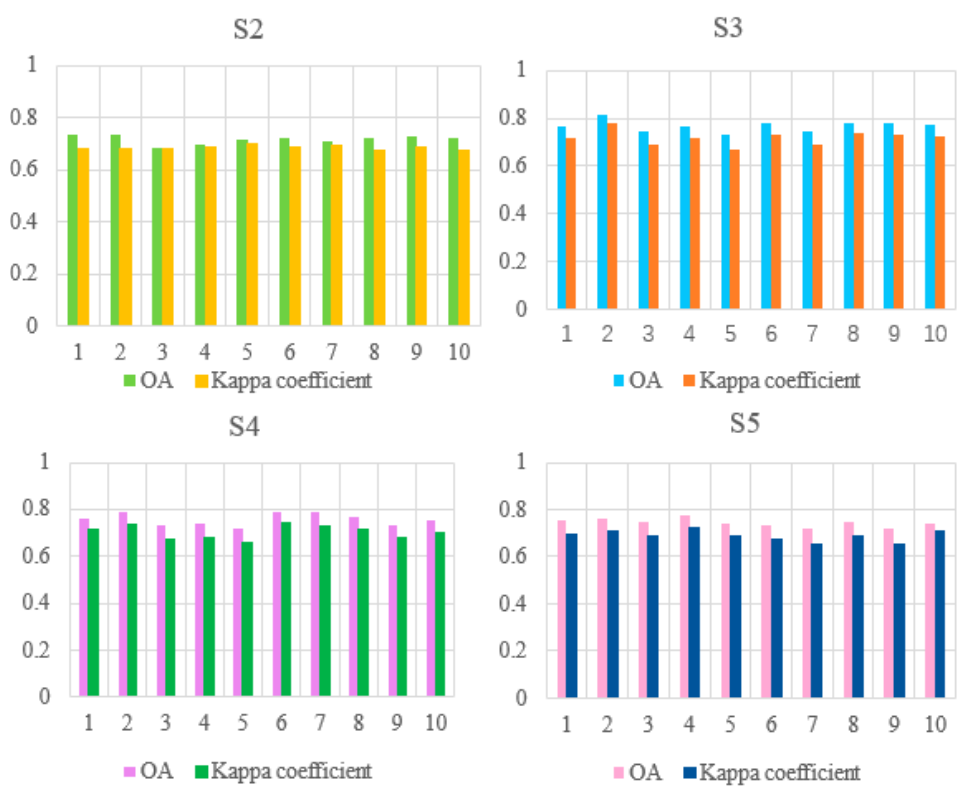
Figure 10. Map of OA and Kappa values for the performance of the models assembled from schemes 2 to 5 in ten experiments.